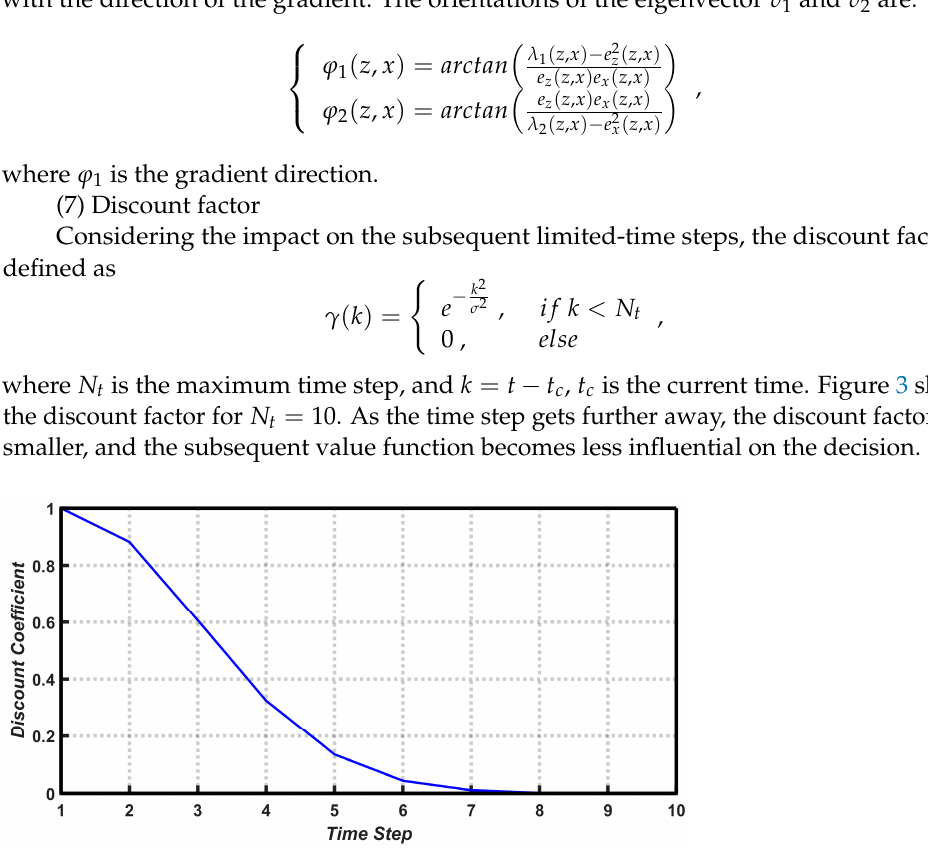
Figure 3. The discount factor for the MDP model.